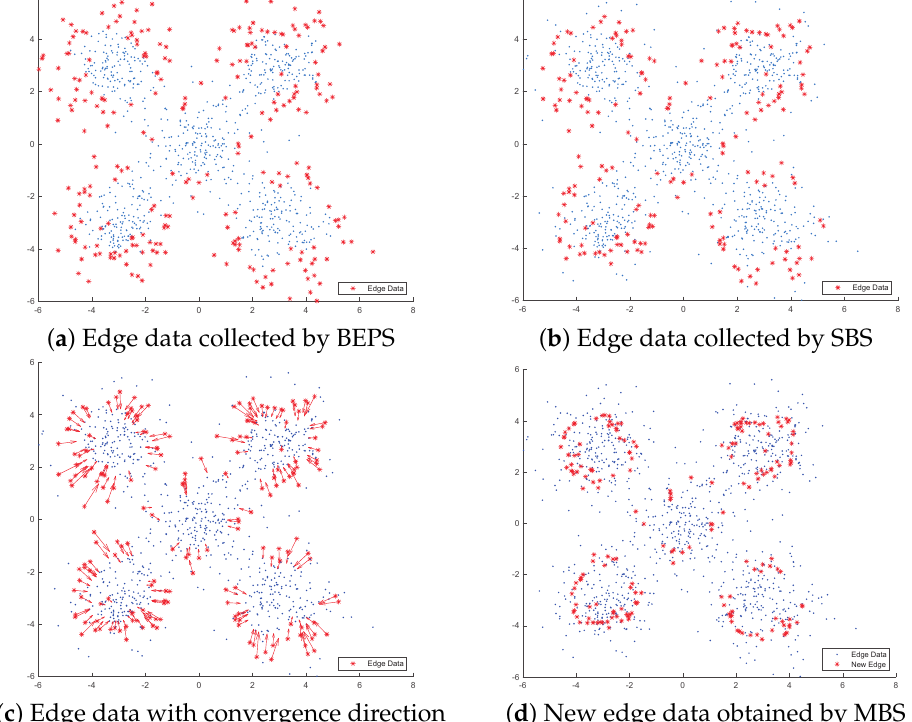
Figure 2. Edge data collected by different boundary selection methods. On the five Gaussians with 1000 data samples equally distributed into fire clusters: ( a ) BEPS [15] collects edge data, with k = 30 and γ = 0.8; ( b ) SBS [8] finds edges, with k = 30, γ l = 0.8, γ u = 0.9; ( c ) Convergence direction description based on the results of SBS; ( d ) MBS obtains new edges not in the original dataset by allowing edges to